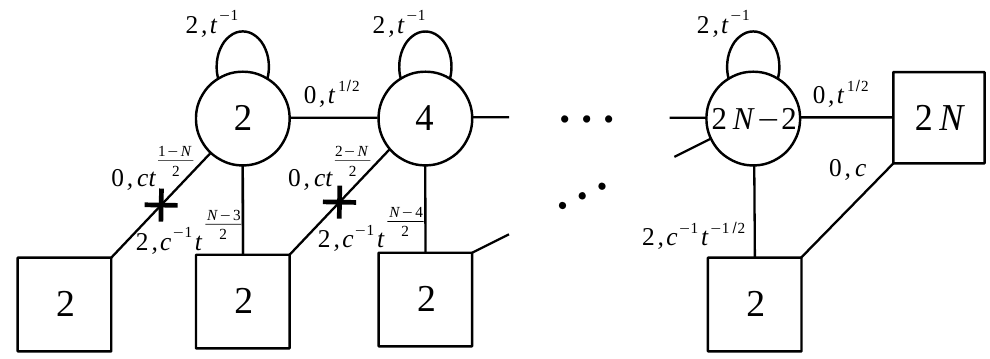
Figure 13 . Trial R-charges and charges under the abelian symmetries. The power of c is the charge under U(1) c , while the power of t is the charge under U(1) t